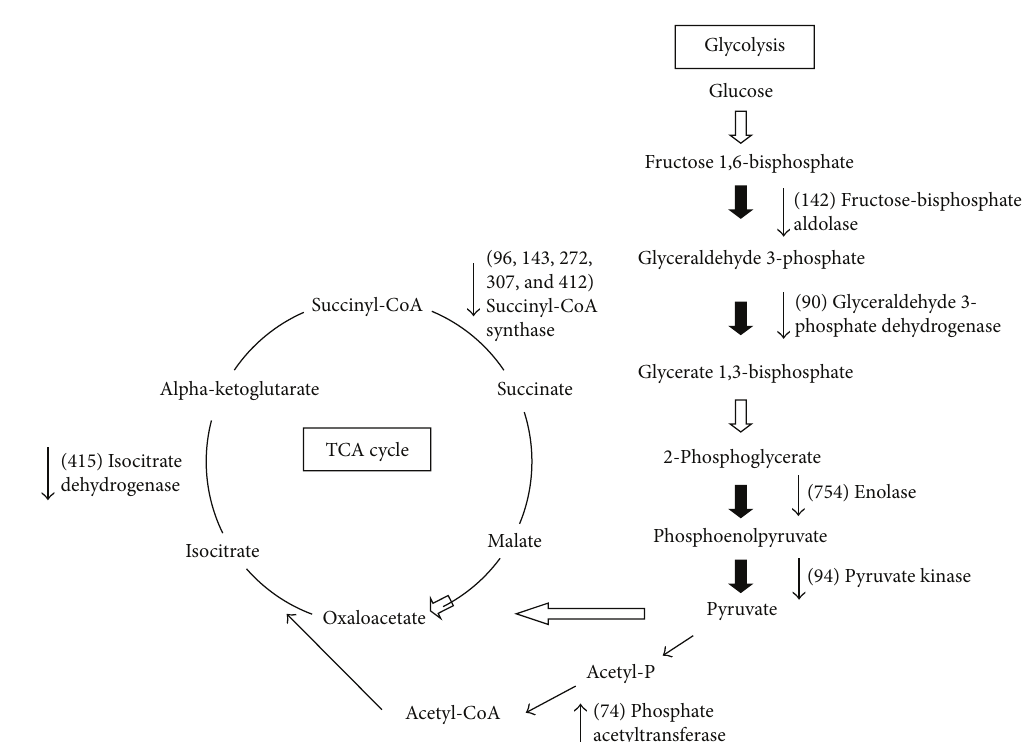
Figure 2: Carbohydrate metabolic pathways in the saeRS mutant under aerobic conditions. The following enzymes (identified in the 2-DE experiment) were found at lower levels in the saeRS mutant: fructose bisphosphate aldolase, glyceraldehyde 3-phosphate dehydrogenase, enolase, pyruvate kinase, succinyl-CoA synthase, and isocitrate dehydrogenase. Phosphate acetyltransferase was found at higher level in the saeRS